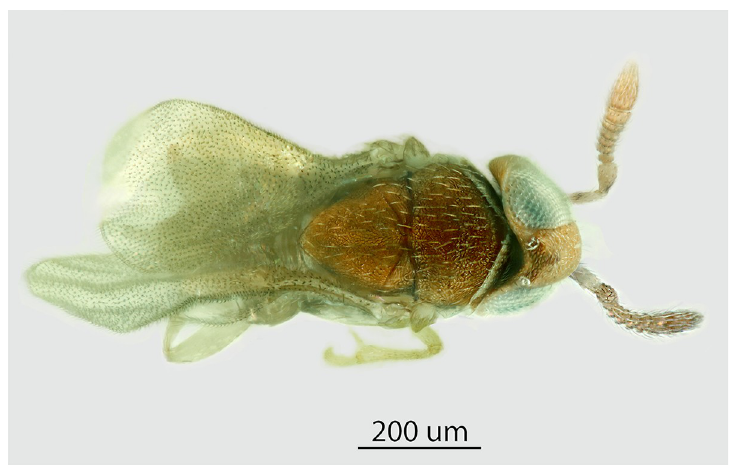
Fig 11. M . macadamiae male, dorsal